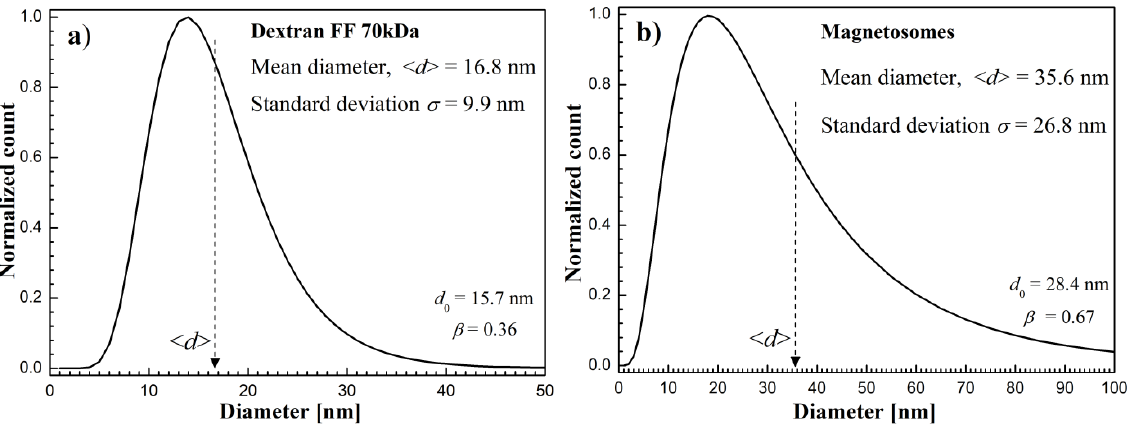
Figure 5. Log-normal particle core size distribution function obtained from VSM data for Dextran FF ( a ) and magnetosomes sample ( b ).